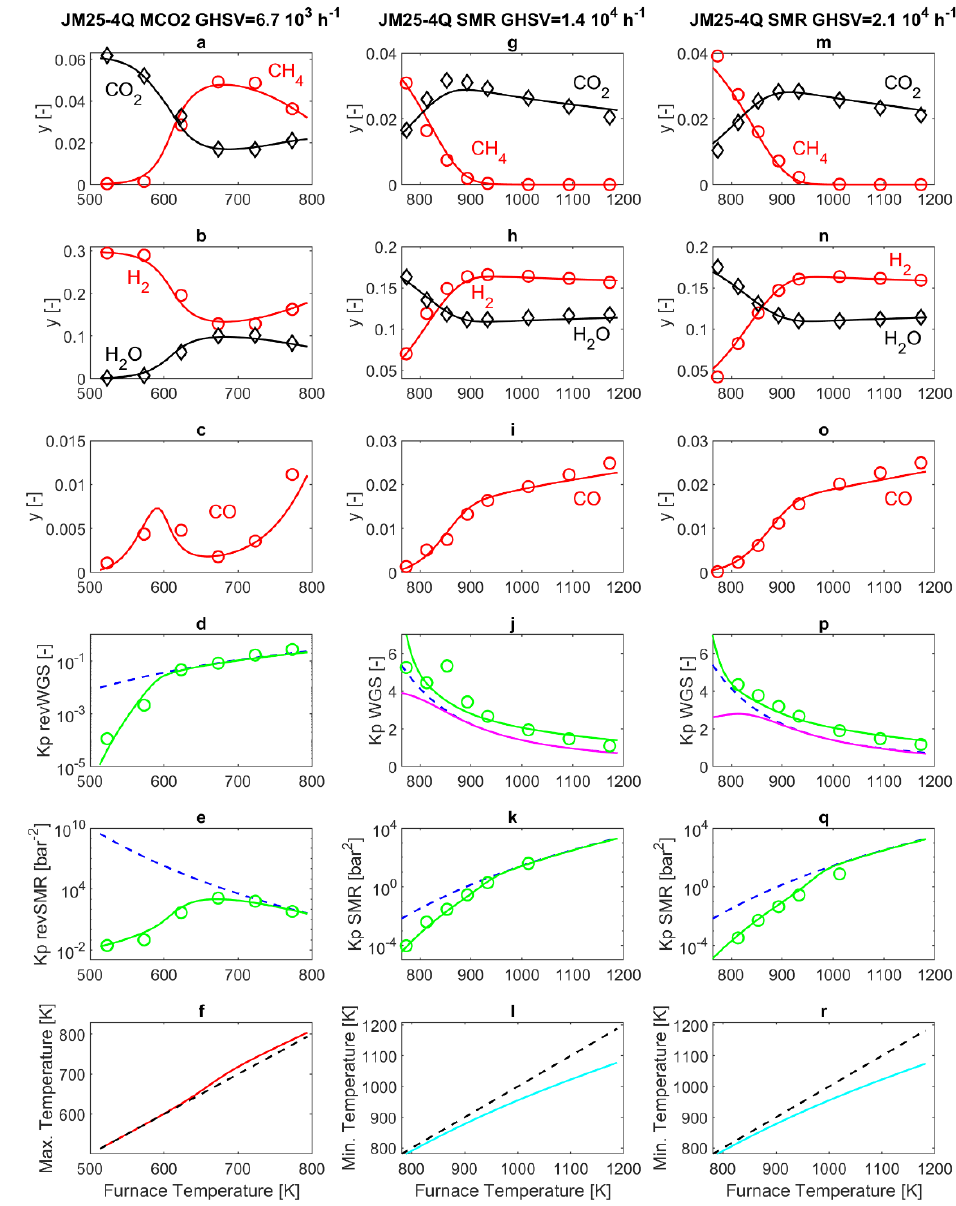
Figure 4. Results for the 25-4Q commercial catalyst. (Panels a – f ): MCO2 operating mode (GHSV = 6.7 × 10 3 h − 1 ). (Panels g – l ): SMR operating mode (GHSV = 1.4 × 10 4 h − 1 ). (Panels m – r ): SMR operating mode (GHSV = 2.1 × 10 4 h − 1 ). Symbols: experimental data. Lines: simulations. (Panels a – c , g – i , m – o ):